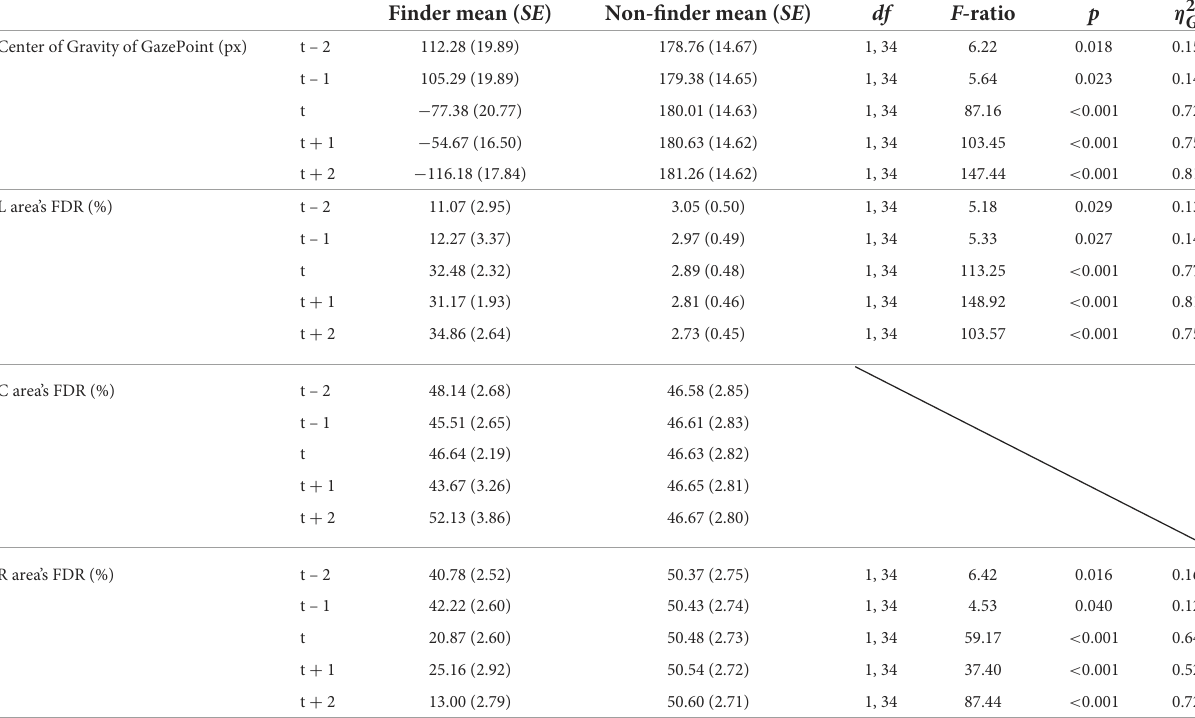
TABLE 2 Basic statistics of the simple main effect during the five trials around the finding reporting trial t .